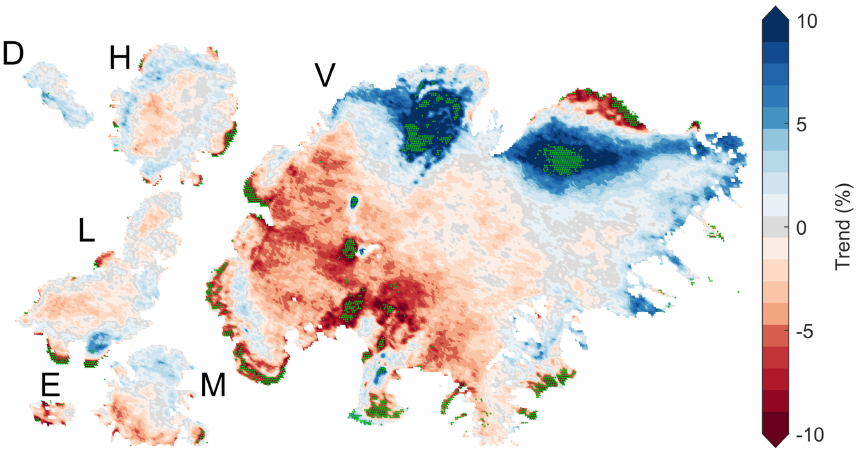
Figure 10. Spatial patterns for albedo trends during the melt season (MJJA) for the period 2000–2019 in terms of the total change of a least-square fit to the albedo over the period. Green stipples indicate areas where significant changes were